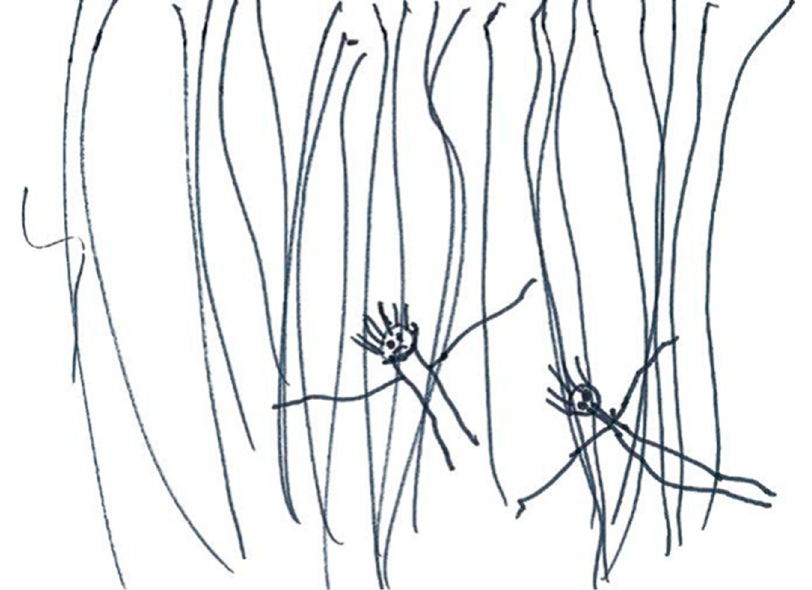
Figure 2. Drawing by preschool school-age girl, held at Christmas Island Detention Center. © Australian Human Rights Commission 2014. The Forgotten Children: National Inquiry into Children in Immigration Detention 2014 .